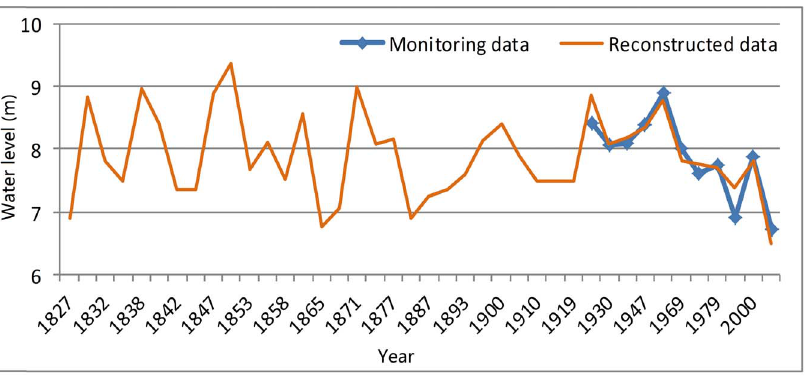
Figure 4. Water level in the Baiyangdian wetland from 1827 to 2006. The water level in the past 200 years reached its peak in the mid-19th century, and fluctuated fiercely between the 1820s and the 1870s and in the 20th century.